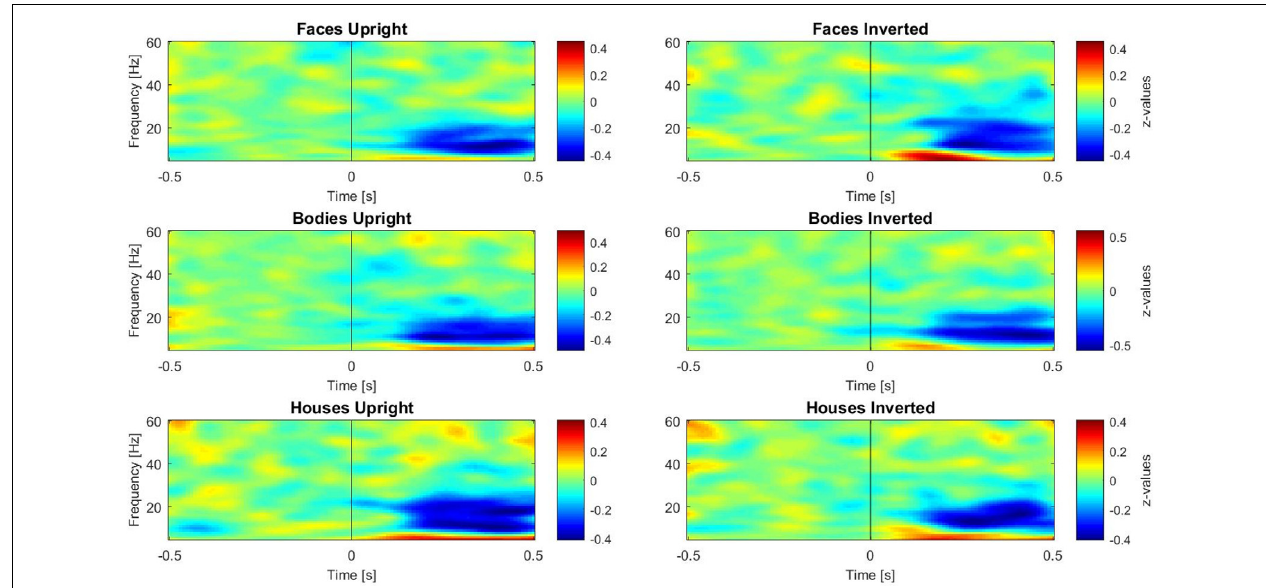
FIGURE 3 | Plots of induced time-frequency activity calculated over 11 right occipito-temporal electrodes and averaged over 23 participants for each category of stimuli. This picture allows the reader to observe differences in patterns of activity for each category, in particular over the theta (5–7 Hz) and gamma (28–45 Hz) bands.